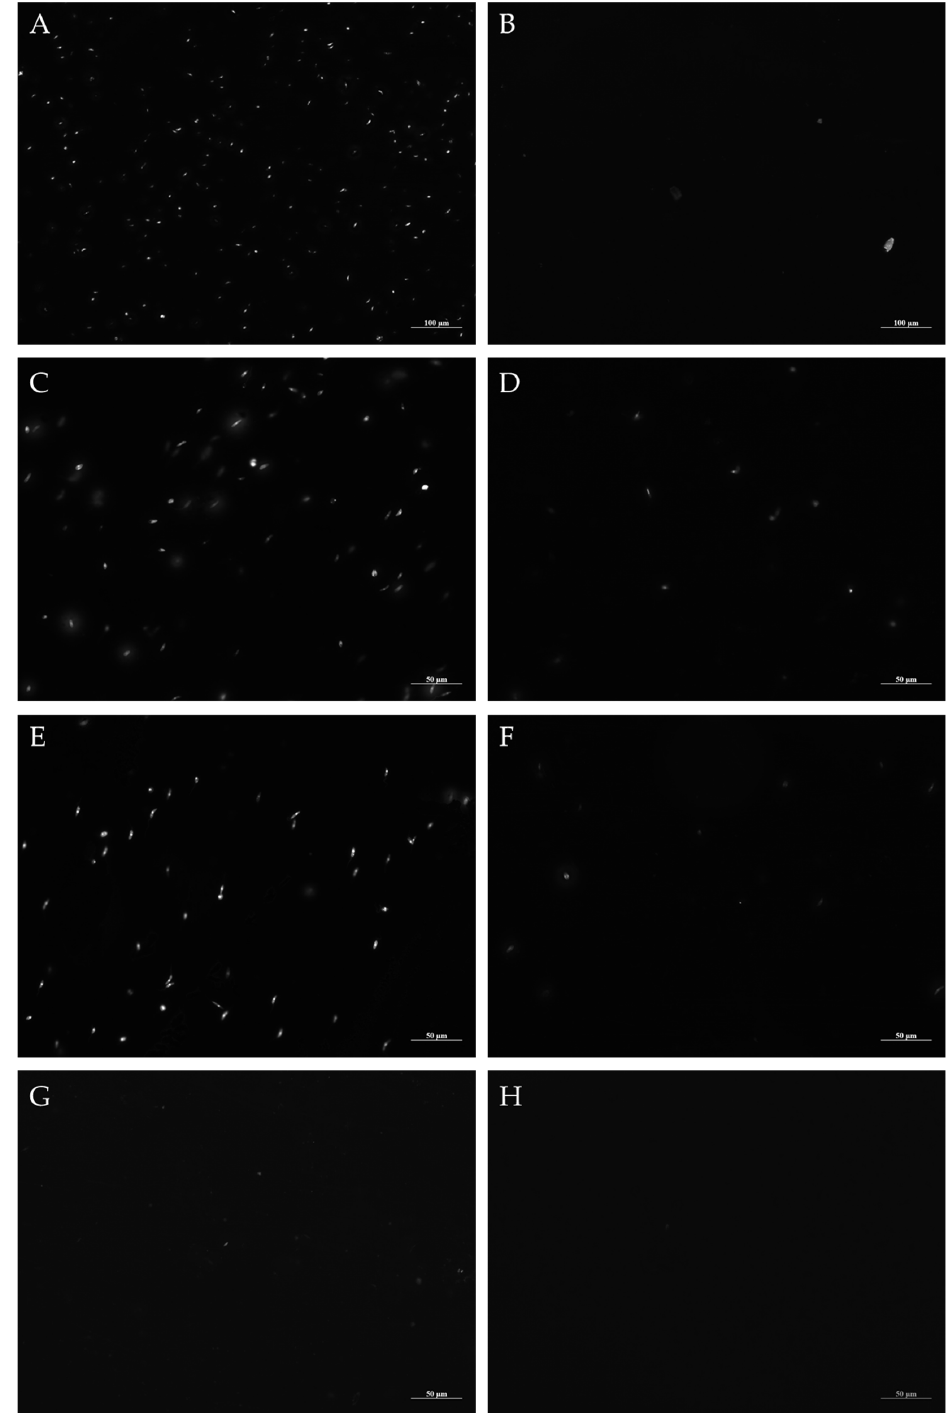
Figure 3. Microscopic fluorescence analysis of promastigote forms of Leishmania amazonensis after treatment for 48 h with natural products of Vernonanthura brasiliana (L.) H. Rob. Viable parasites were labeled with acridine orange and presented in dark field. ( A ) Parasites in Schneider medium ; ( B ) Parasites with 70% methanol; ( C ) Parasites with EB Vb -IC 50 ; ( D ) Parasites with EB Vb -2xIC 50 ; ( E ) Parasites with FH Vb -IC 50 ; ( F ) Parasites with FH Vb -2xIC 50 ; ( G ) Parasites with Amphotericin-B-IC 50 ; ( H ) Parasites with amphotericin-B-2xIC 50 . To capture the images, the Alexa filter (488 nm) was used in the Zeiss ® Axio Fluorescence Microscope Imager (50 μ m and 100 μ m).